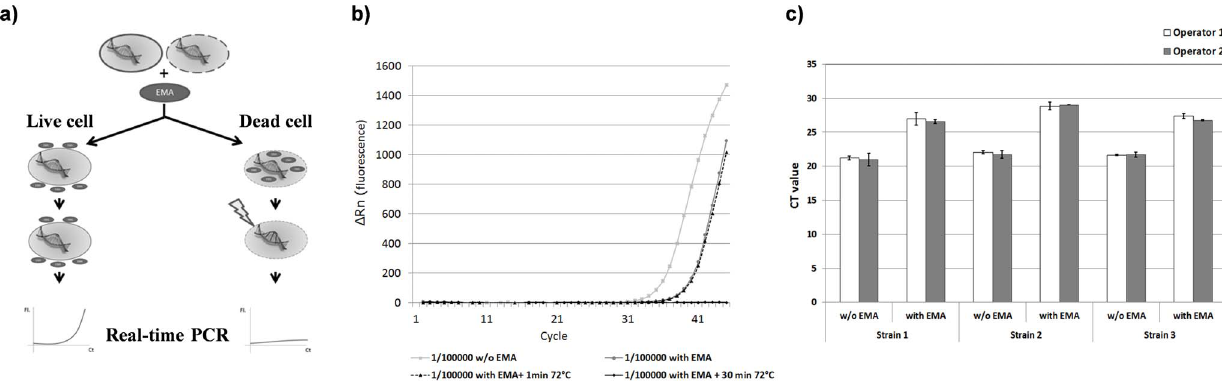
Figure 2. Use of EMA-PCR for enumerating living C.burnetii cells. Ethidium monoazide (EMA)-PCR was used to count live C. burnetii cells. A) Schematic representation of the EMA-PCR principle. EMA is unable to diffuse through intact bacterial cells with a non-damaged cell wall.